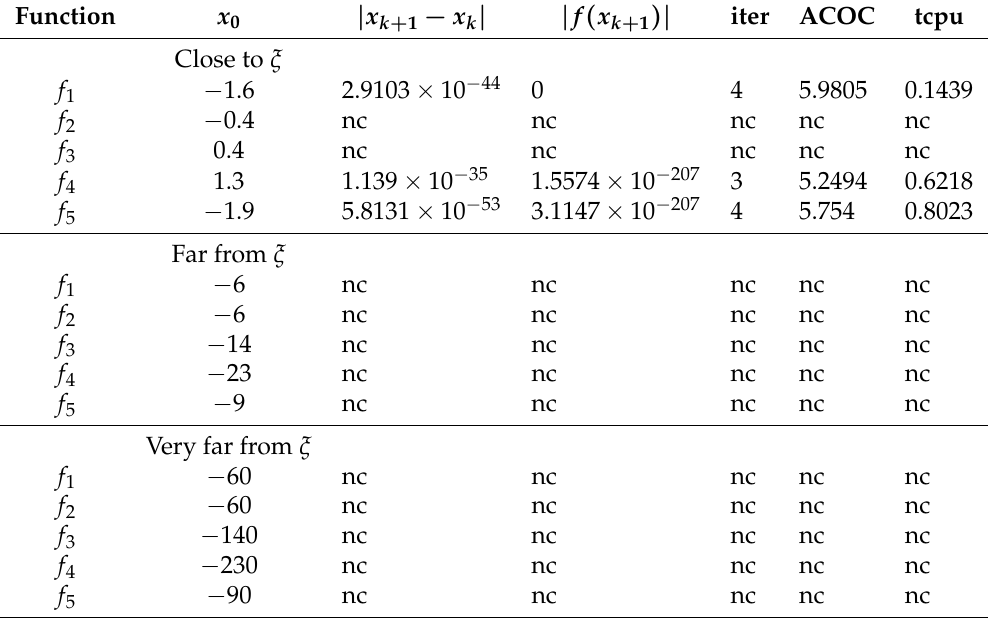
Table 9. Numerical performance of CMT (400) method in nonlinear